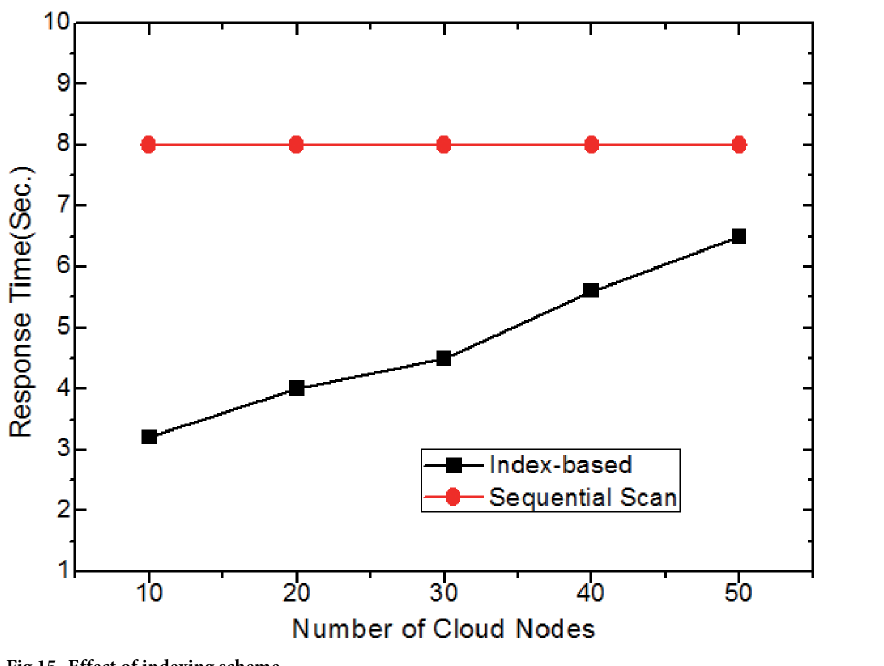
Fig 15. Effect of indexing